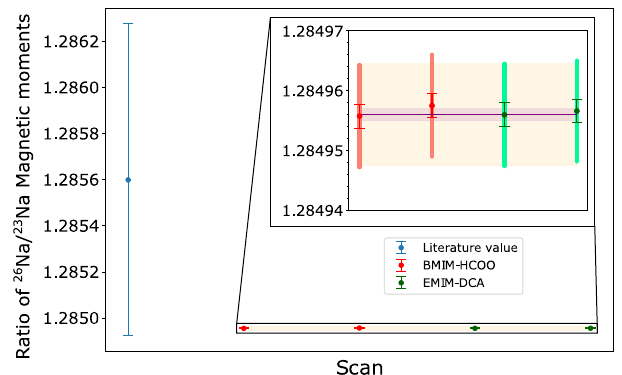
FIG. 4. Ratio of the magnetic moments of 26 Na and 23 Na. Left: Literature value [68]; right: present study. Thin error-bar lines correspond to statistical uncertainty in the 26 Na Larmor fre- quency, and thick lines are the systematic uncertainties. The weighted average is represented by the purple line. The statistical uncertainty from all four measurements is indicated by the pink band, while the systematic uncertainty is shown by the broader orange band. For details, see the text.